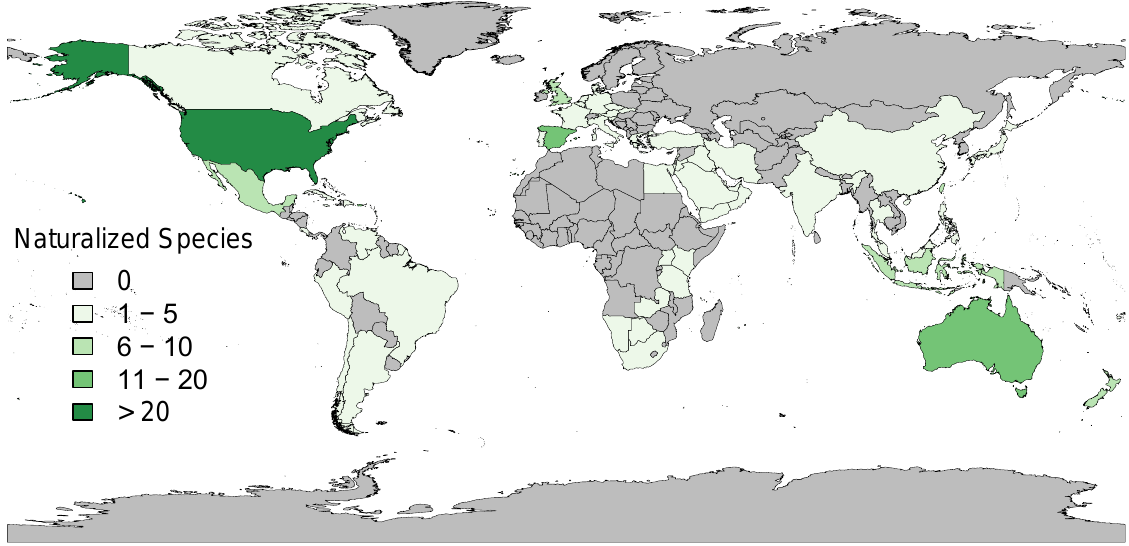
Figure 1. The distribution of naturalized and breeding species of parrots (Psittaciformes), according to the GAVIA (Dyer et al., 2017) dataset. The map depicts how many species of introduced Psittaciformes are naturalized or breeding per country. See text for definitions.